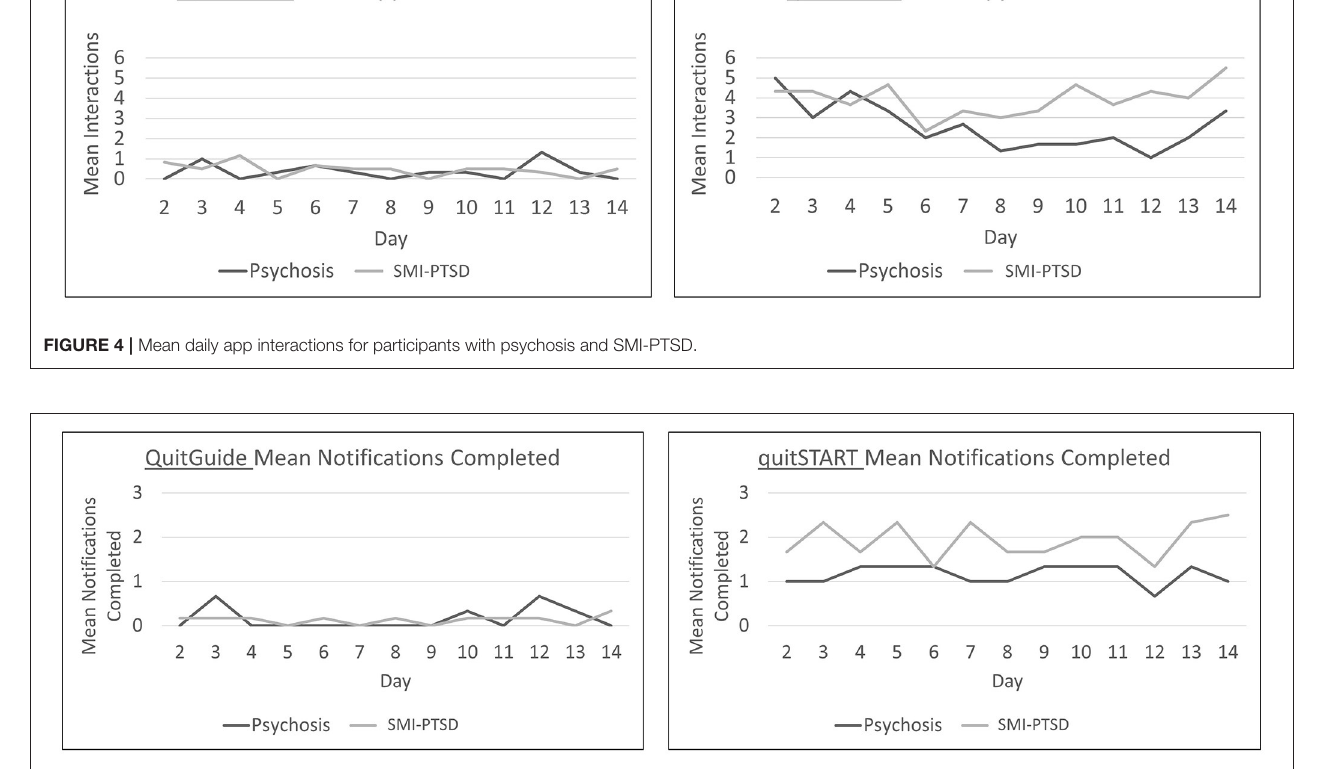
FIGURE 5 | Mean daily completed notifications for participants with psychosis and